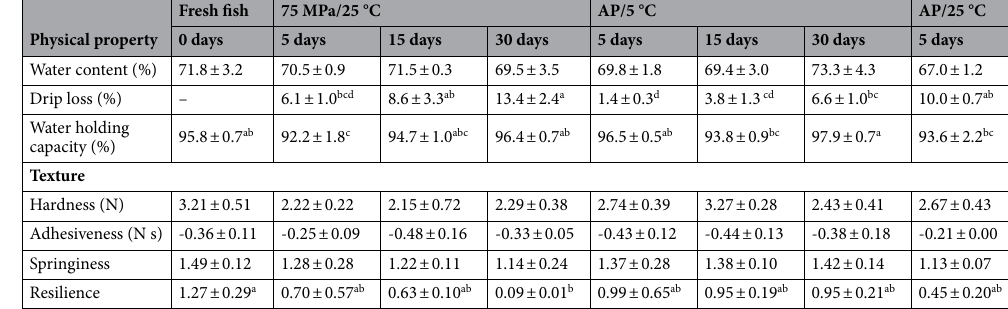
Table 3. Physical properties of Atlantic salmon stored at 75 MPa/25 °C and AP/5 °C during 30 days, and at AP/25 °C during 5 days. Different letters along each row denote significant differences (p < 0.05); absence of letters indicates not statistically significant